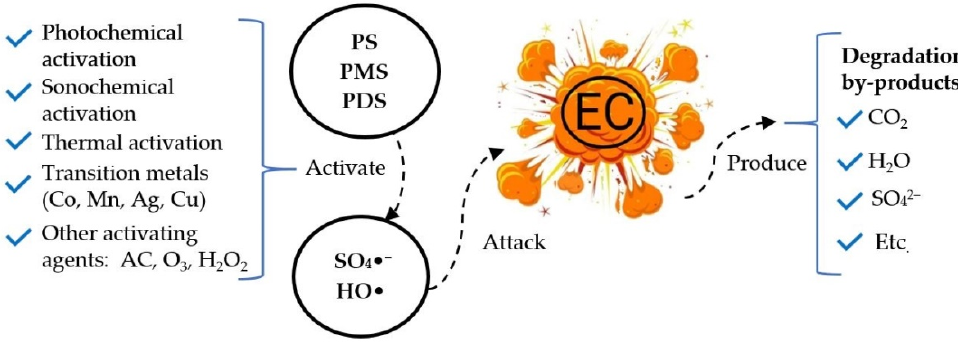
Figure 3. Advanced oxidation processes based on sulfate radicals (SO 4 • − ).